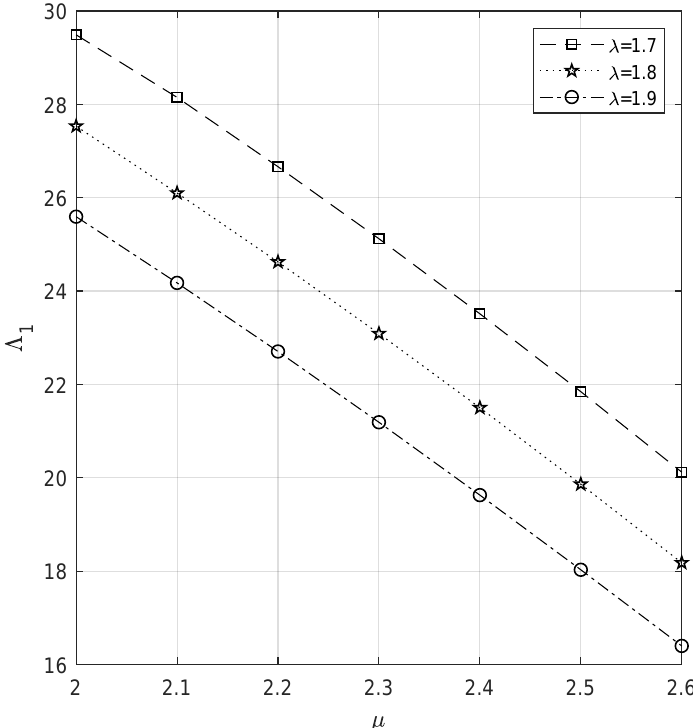
Figure 11. The impact of mean inventory level when λ vs. µ .